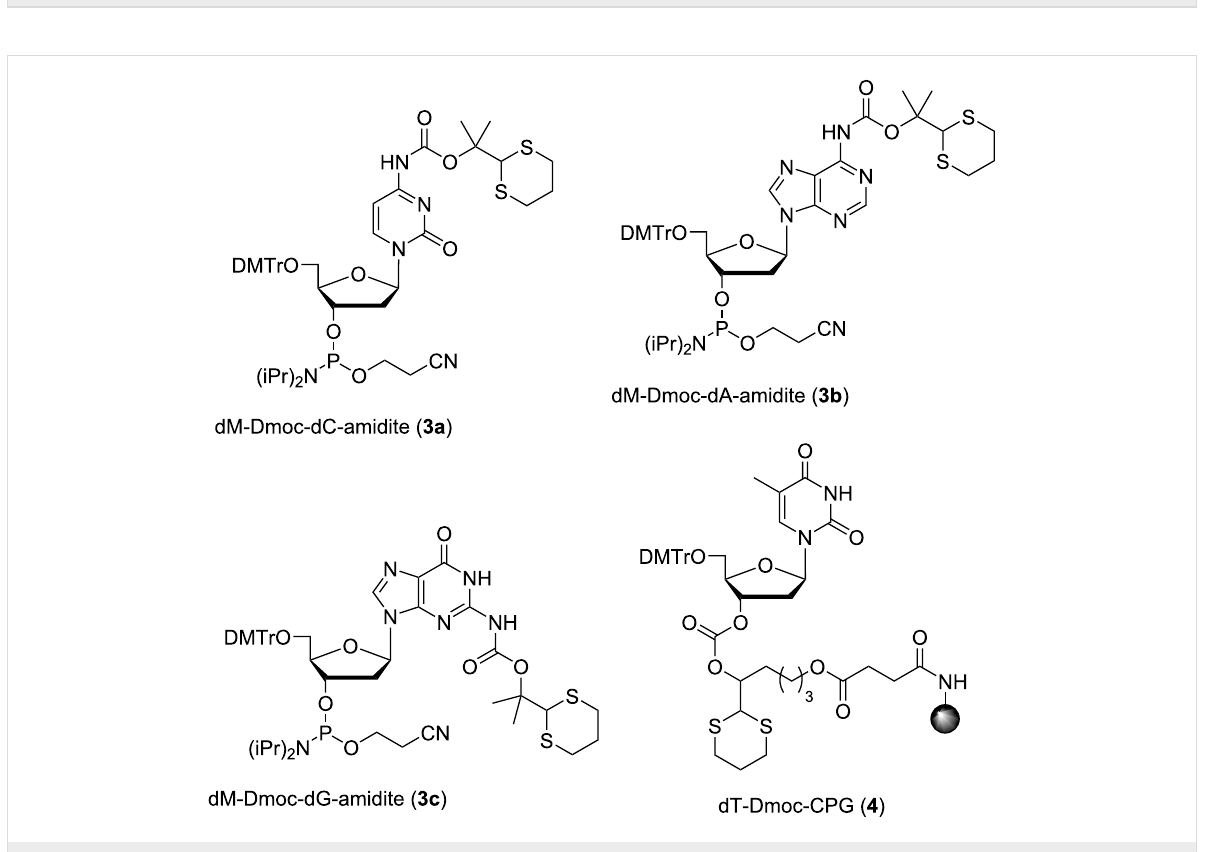
Figure 1: dM-Dmoc phosphoramidite monomers and CPG with Dmoc